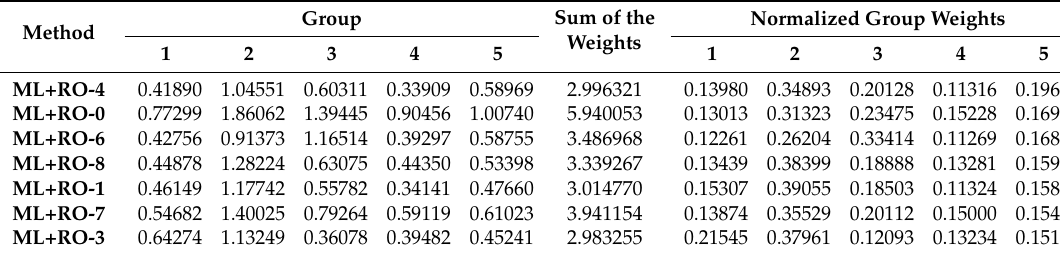
Table 2. Weights of attribute groups in the training set.